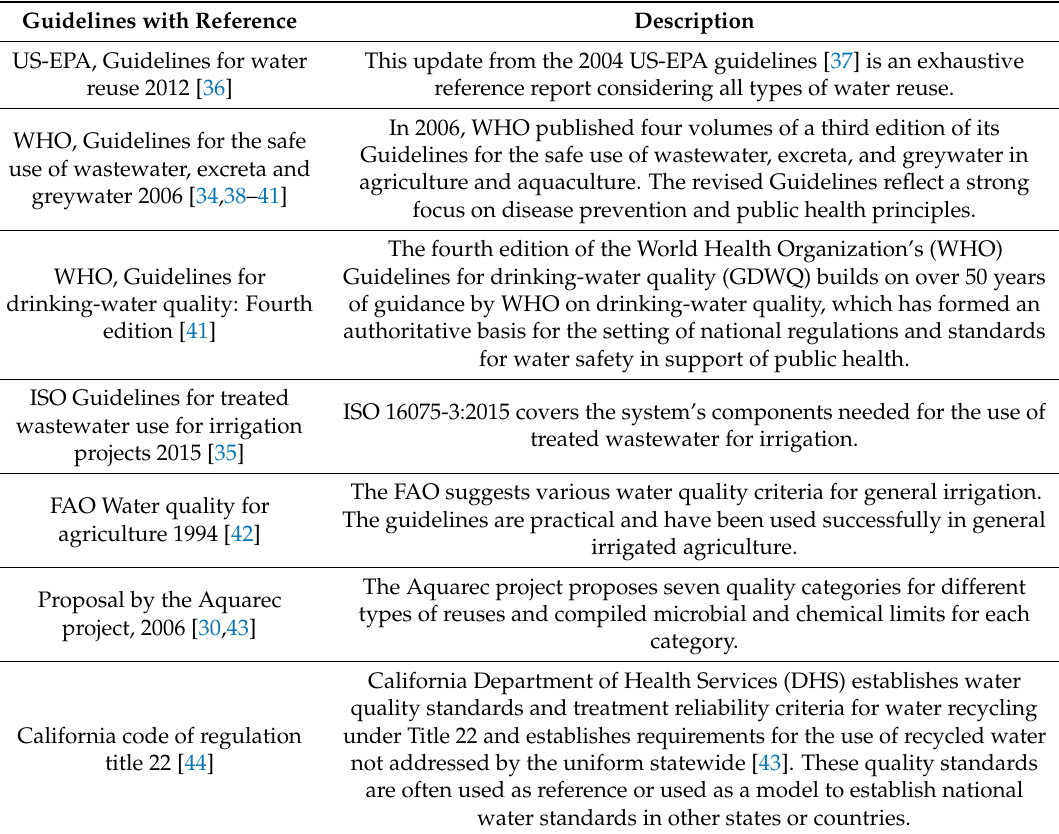
Table 5. Overview of most prominent international guidelines and standards for treated WW